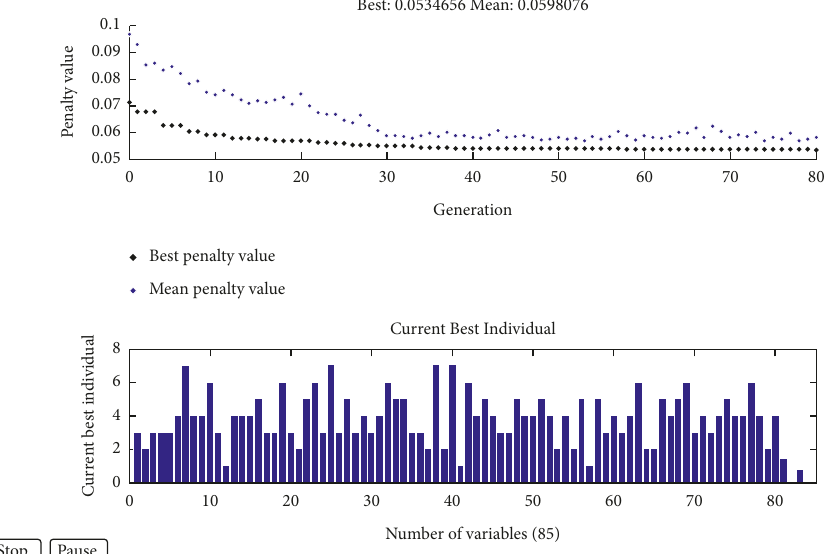
Figure 4: Fuzzy genetic algorithm training process and bar graphs of variables for El Centro earthquake.